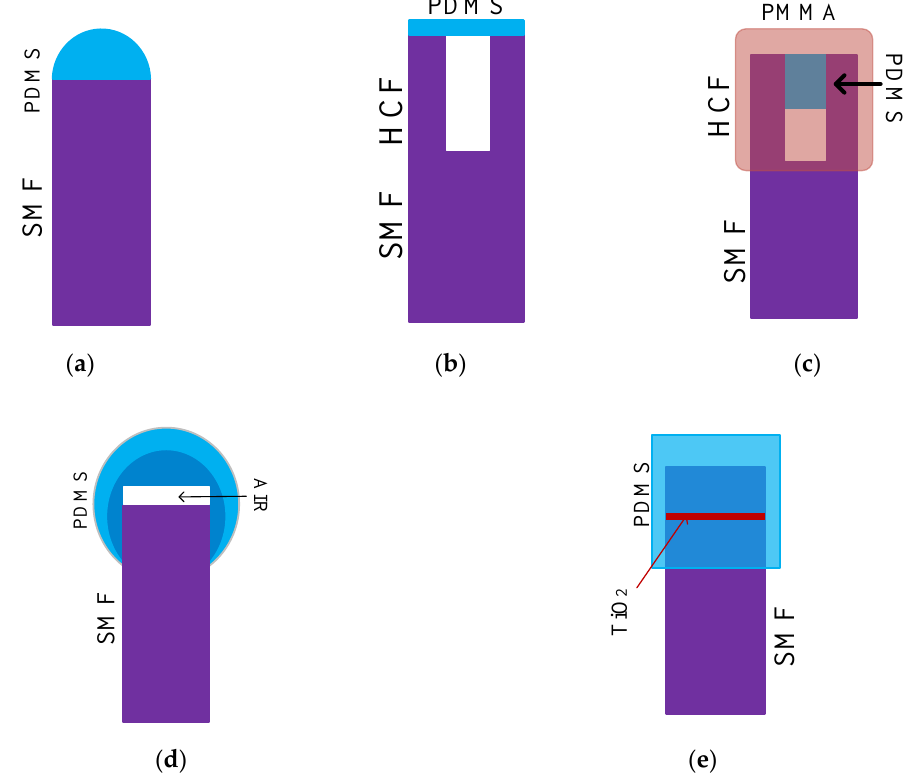
Figure 7. The descriptions of different F-P sensors: ( a ) The F-P sensor consists of SMF and PDMS [35]; ( b ) F-P sensor consists of SMF, HCF, and PDMS [36]; ( c ) F-P consists of SMF, HCF filled with PDMS and a PMMA (polymethylmethacrylate) protective layer [37]; ( d ) Sensor structure consists of SMF, air cavity, and two-PDMS layers [38]; ( e ) Sensor consists of SMF with the TiO 2 layer and PDMS